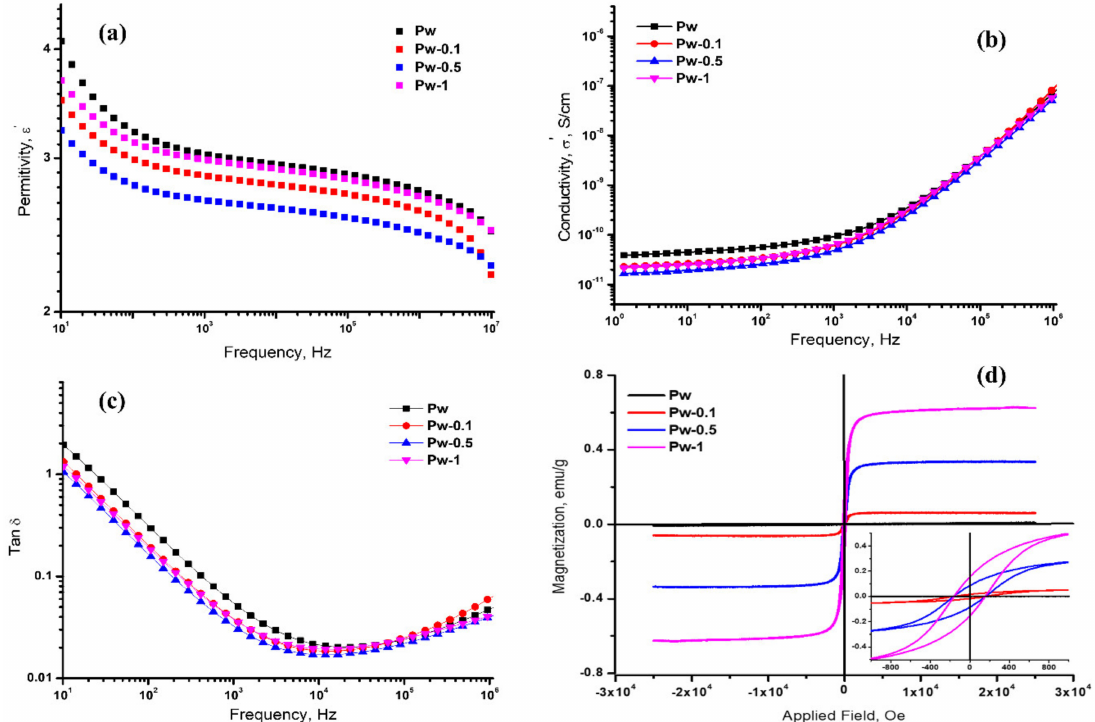
Figure 11. Frequency dependencies of ( a ) dielectric permittivity, ( b ) conductivity, ( c ) loss tangent, and ( d ) field-dependent magnetization curves of PU-based composite membranes prepared in wet conditions with different amounts of